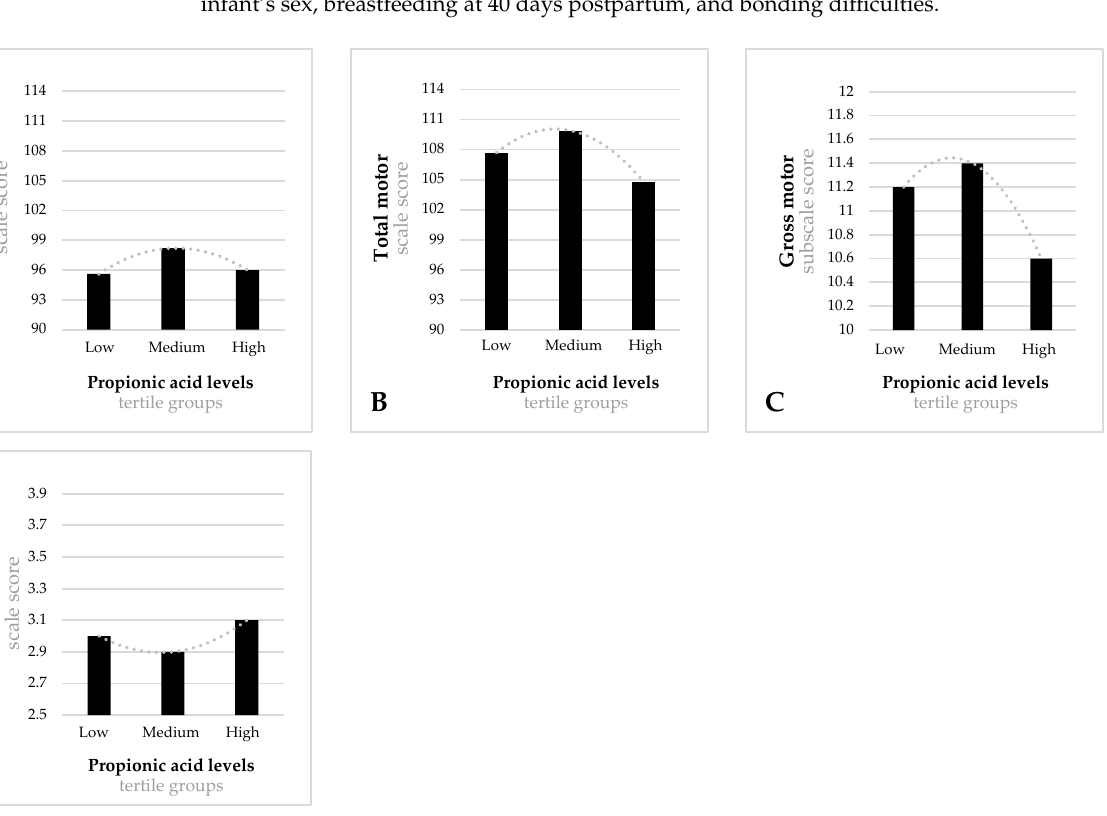
= 1.5), high-tertile mean score = 7.9 (SD = 1.8). Model F = 3.308; p = 0.038. ( B ) Low-tertile mean score = 8.2 (SD = 1.5), medium-tertile mean score = 8.1 (SD = 1.6), high-tertile mean score = 7.7 (SD = 1.5). Model F = 3.543; p = 0.030. Models adjusted for mother’s age, family’s socioeconomic status, first/third trimester state anxiety, smoking during pregnancy, first/third trimester quality of diet, first/third trimester BMI, mode of delivery, gestational age at birth, infant’s birth weight, infant’s sex, breastfeeding at 40 days postpartum, and bonding difficulties.